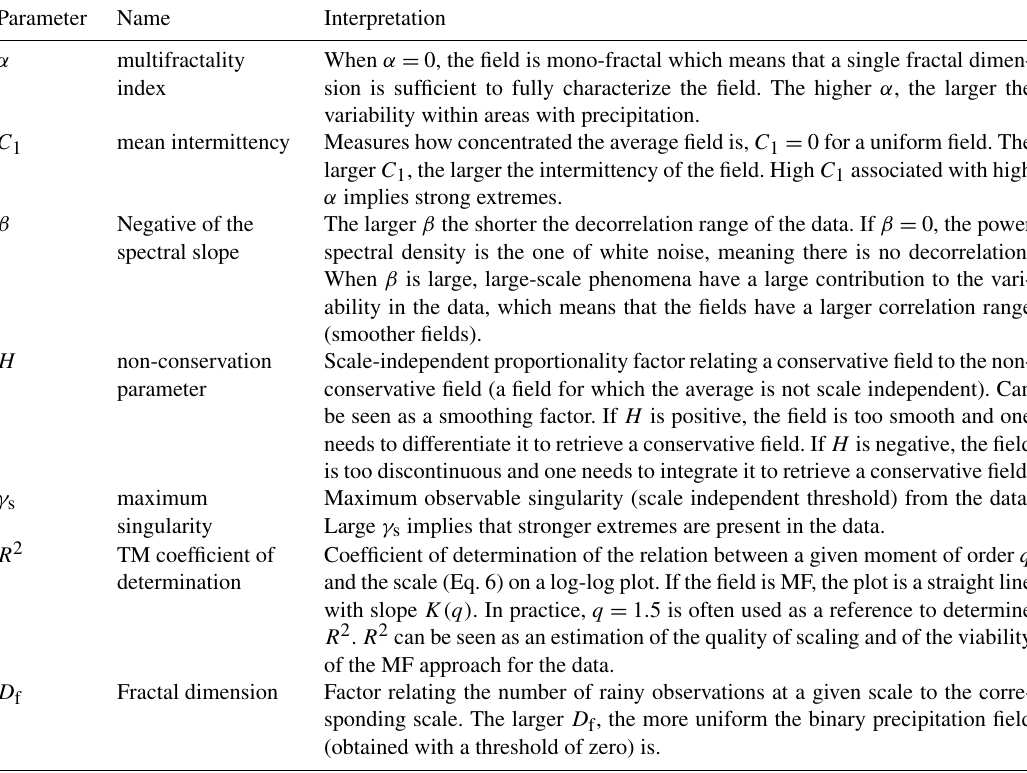
Table 3. Overview of all MF